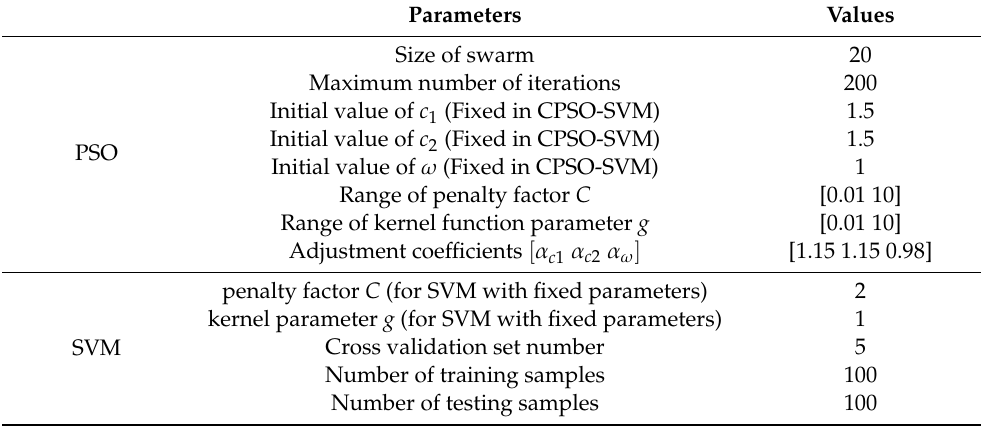
Table 3. Parameter configuration for the three contrastive methods.